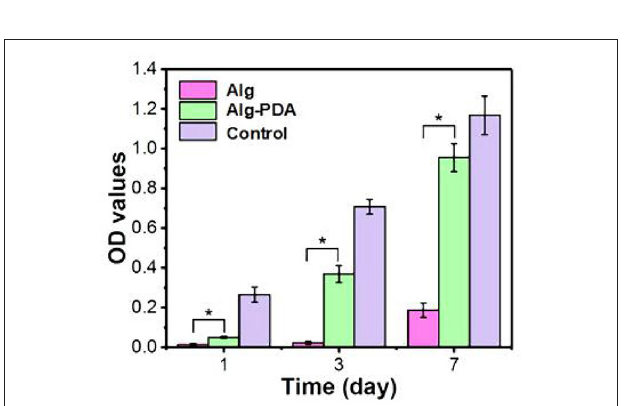
FIGURE 3 | Proliferation of MCF-10A cells seeded on 3D-printed Alg, Alg-PDA, and 48-well plate (control) scaffolds during seven days of culture. © 2019 Acta Materialia Inc. Published by Elsevier Ltd. All rights reserved (20). *indicates statistically